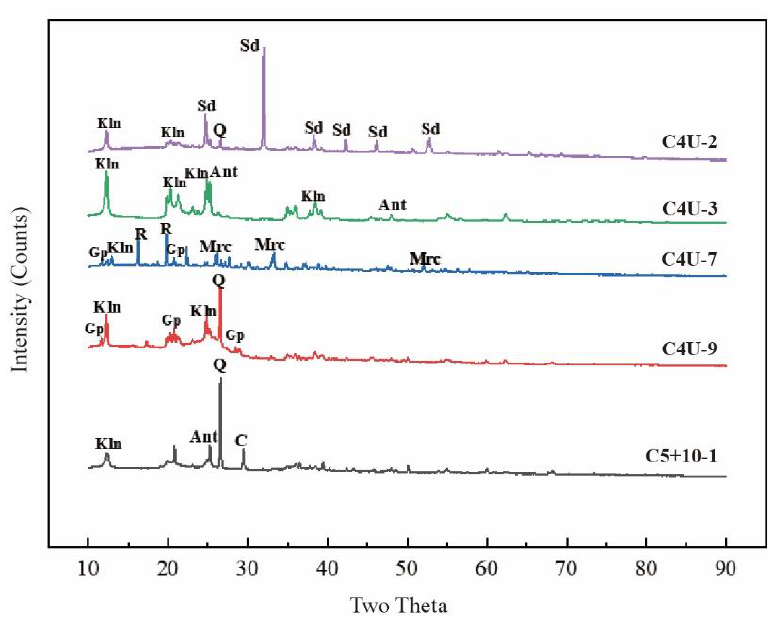
Figure 8. The XRD pattern of the selected samples. Note: The samples are raw coals or carbonaceous mudstones. Kln kaolinite, Sd siderite, Q quartz, Ant anatase, Gp gypsum, R rozenite, Mrc marcasite, C calcite.